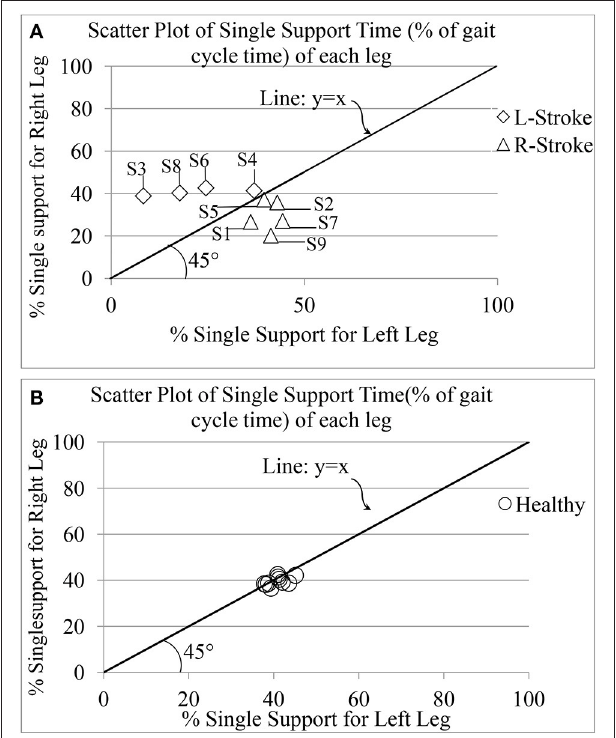
FIGURE 9 | Comparative presentation of single limb support time of each leg for (A) post-stroke and (B) healthy individuals. R-Stroke, post-stroke patients with right hemiplegia stroke; L-Stroke, post-stroke patients with left hemiplegia.